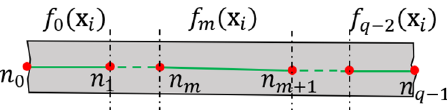
Figure 7. A schematic diagram for spline fitting using extracted control points on a road cluster.